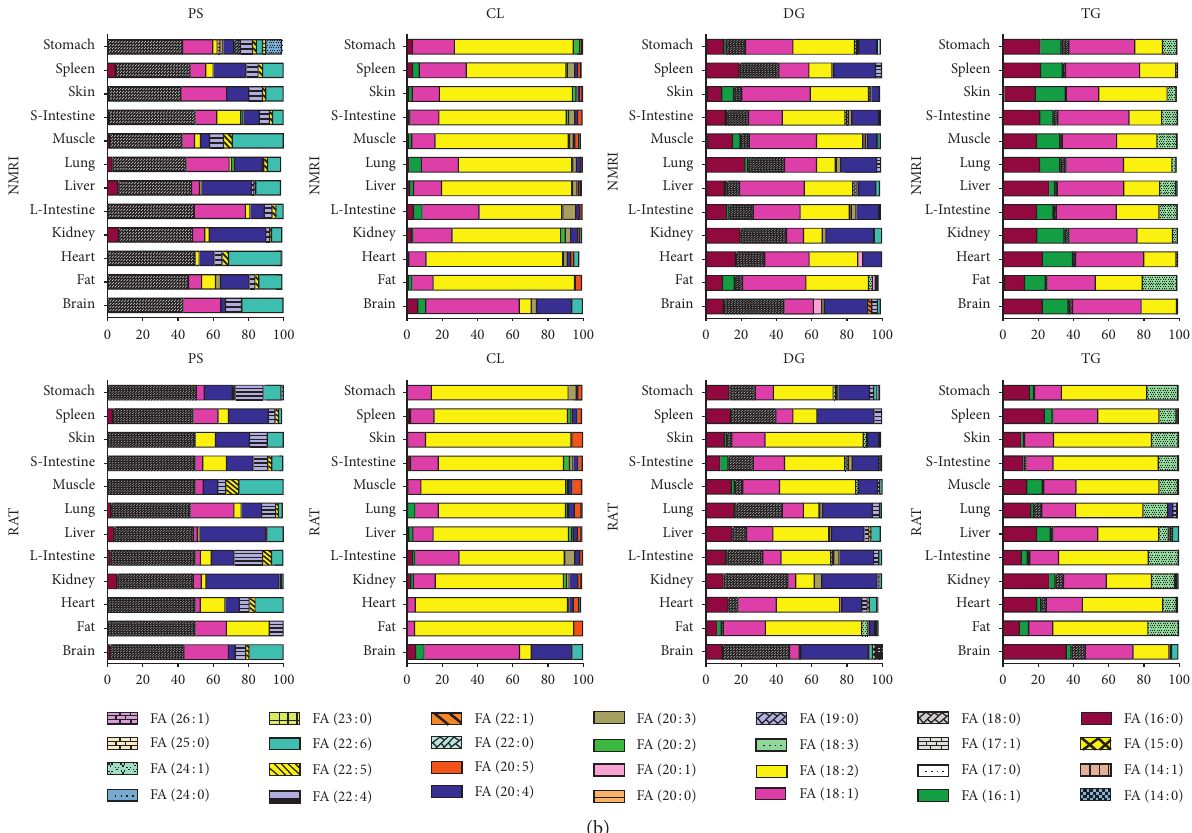
Figure 2: Acyl chain percentage compositions of PE, PC, PI, PG, PS, CL, DG, and TG in 12 organs/tissues of CD1, NMRI mice, and rats ( n � 9). Each color represents a different fatty acid chain. The acyl chains with less than 1% were not included in the figures for better